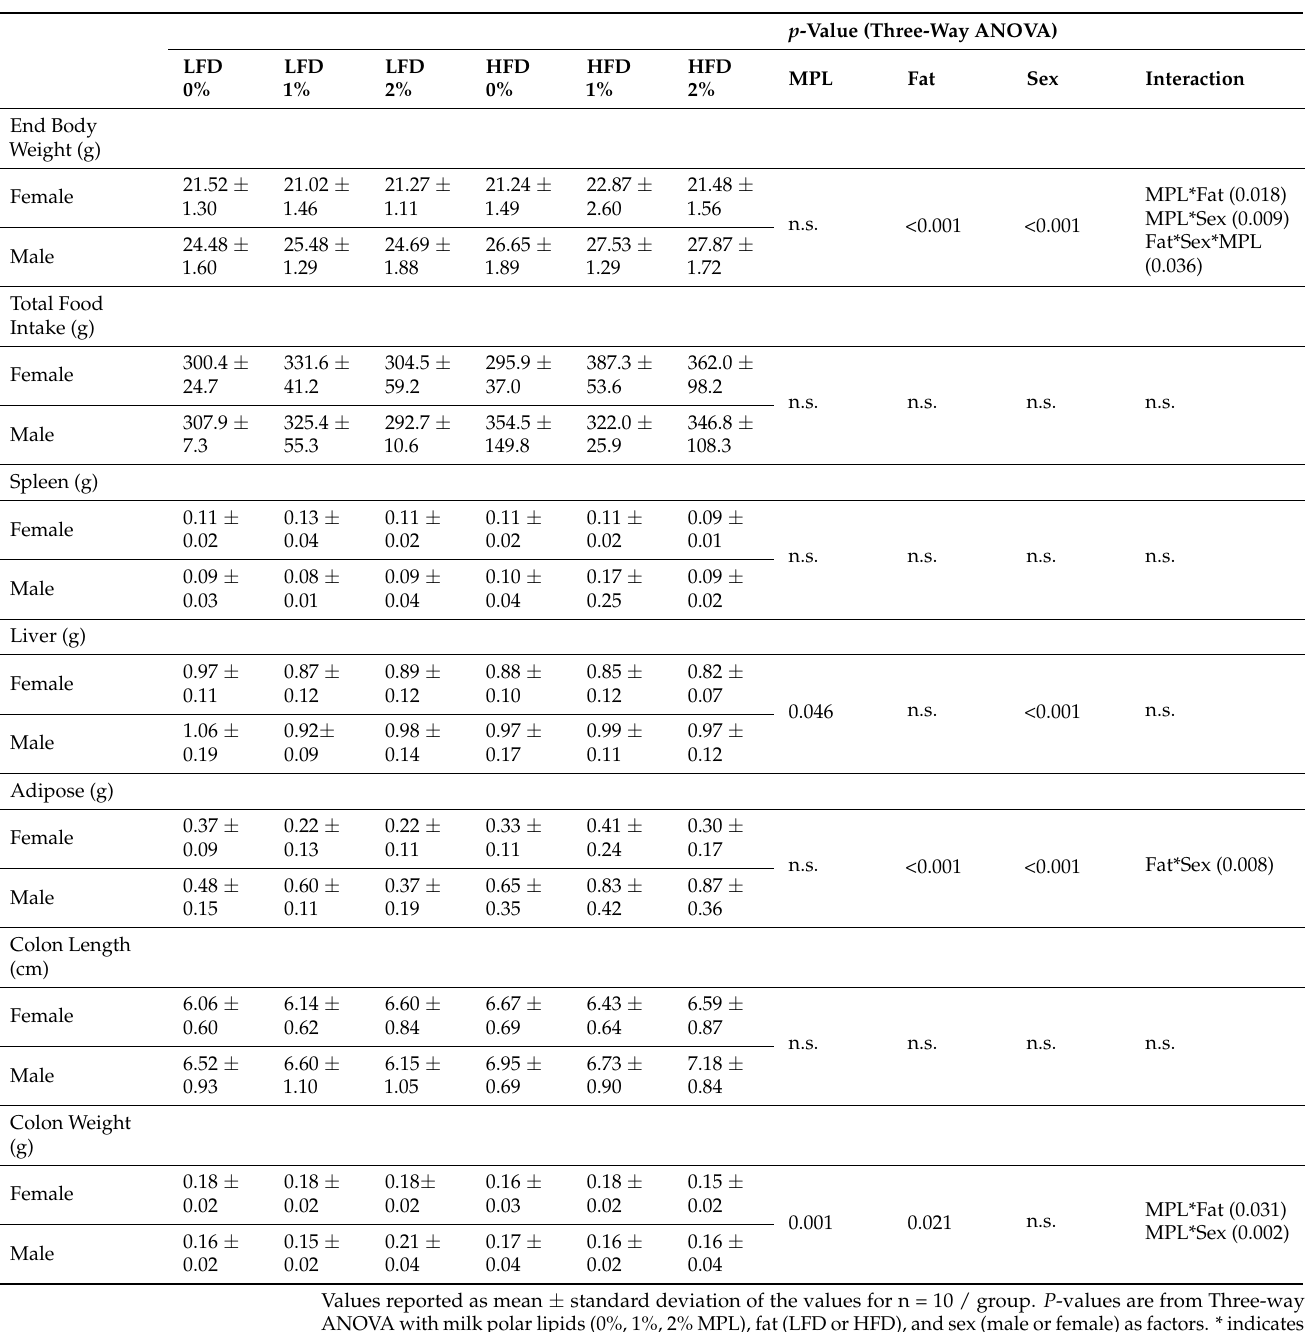
Table 3. Body, Tissue Weights, and Food Intake.